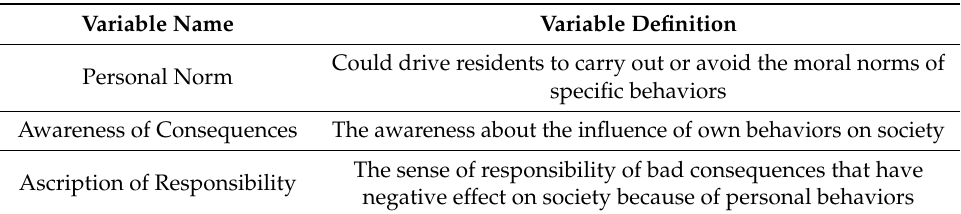
Table 1. Variable definition of